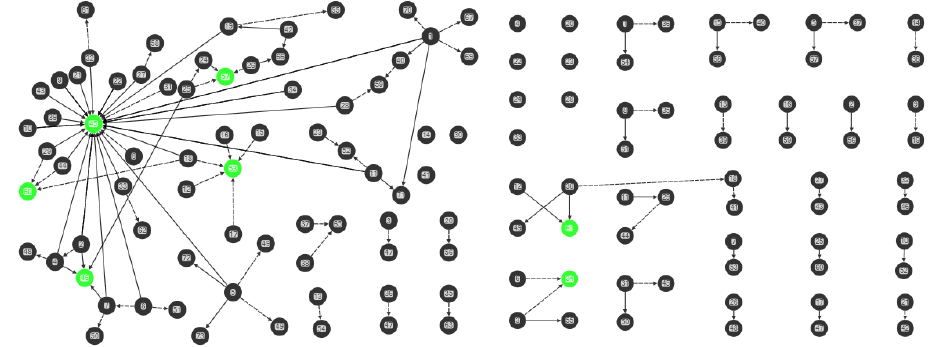
Figure 2. Centrality in the combined mothers’ health advice-seeking network (Q15, Q23). “Rural 1” left hand side and “Urban 1” right side. Green nodes indicate individuals with high in-degree scores (greater than three), black ties denote health advice nominations and black dashed ties denote general advice nominations.